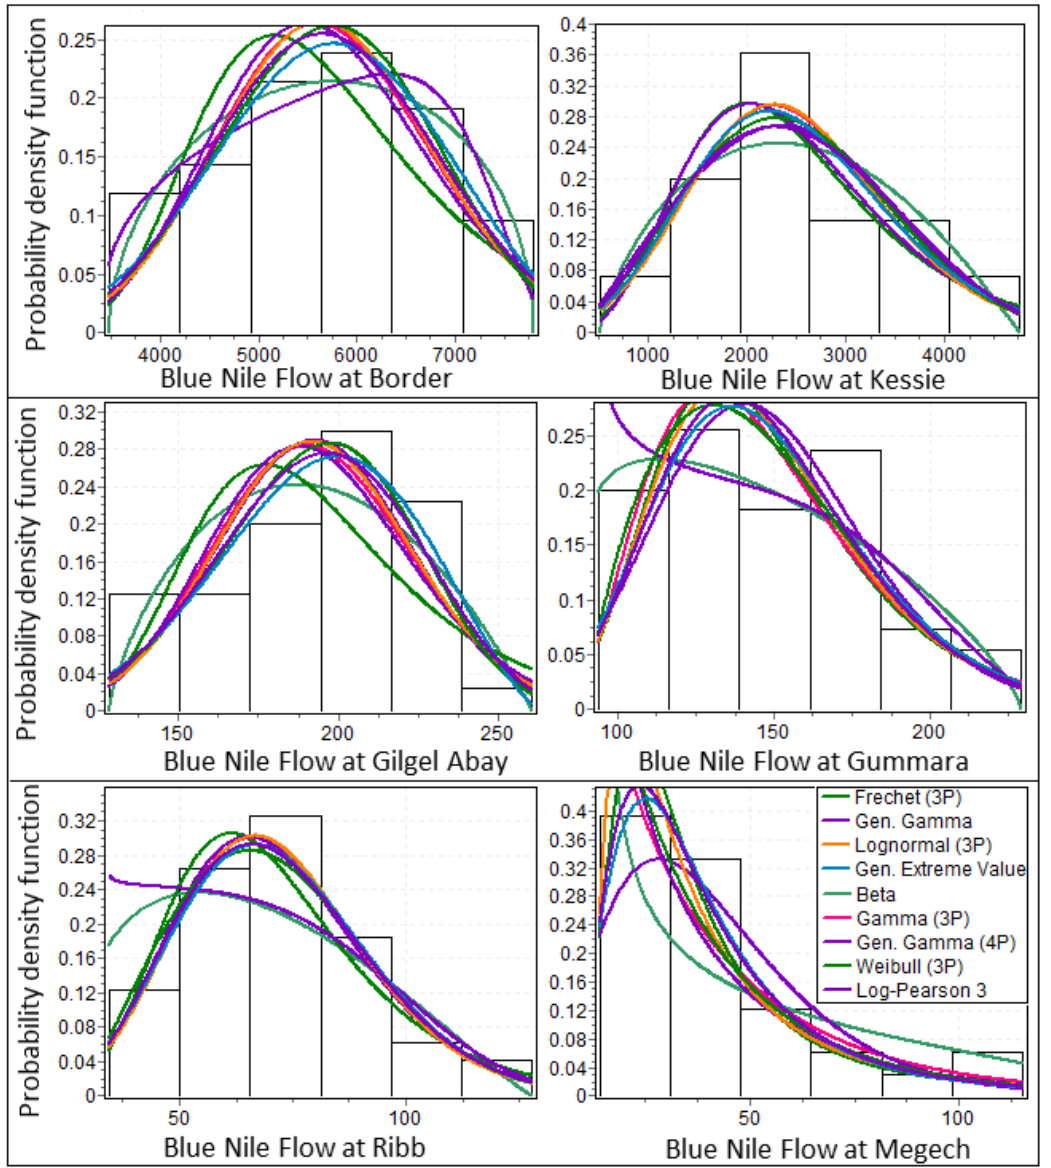
Figure 3. Probability density functions of the candidate distributions in all gauging stations.